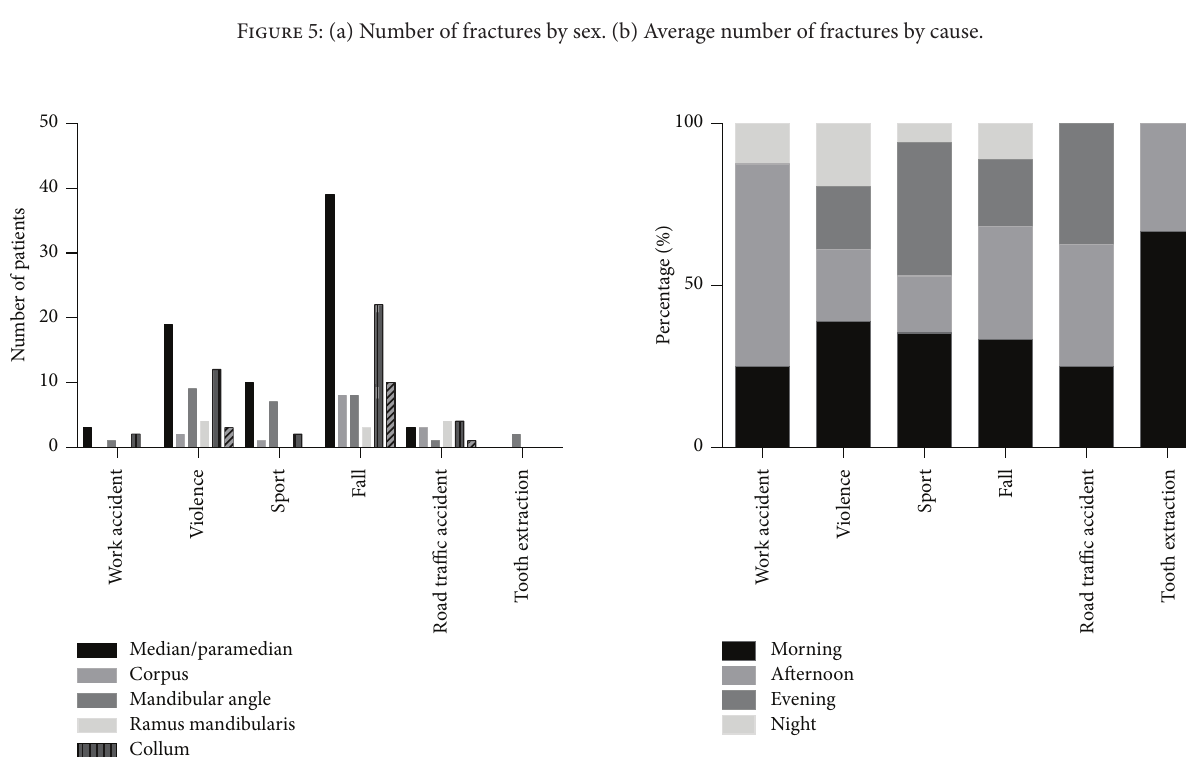
Figure 7: Number of patients presented with suspected mandibular fractures by cause and time of